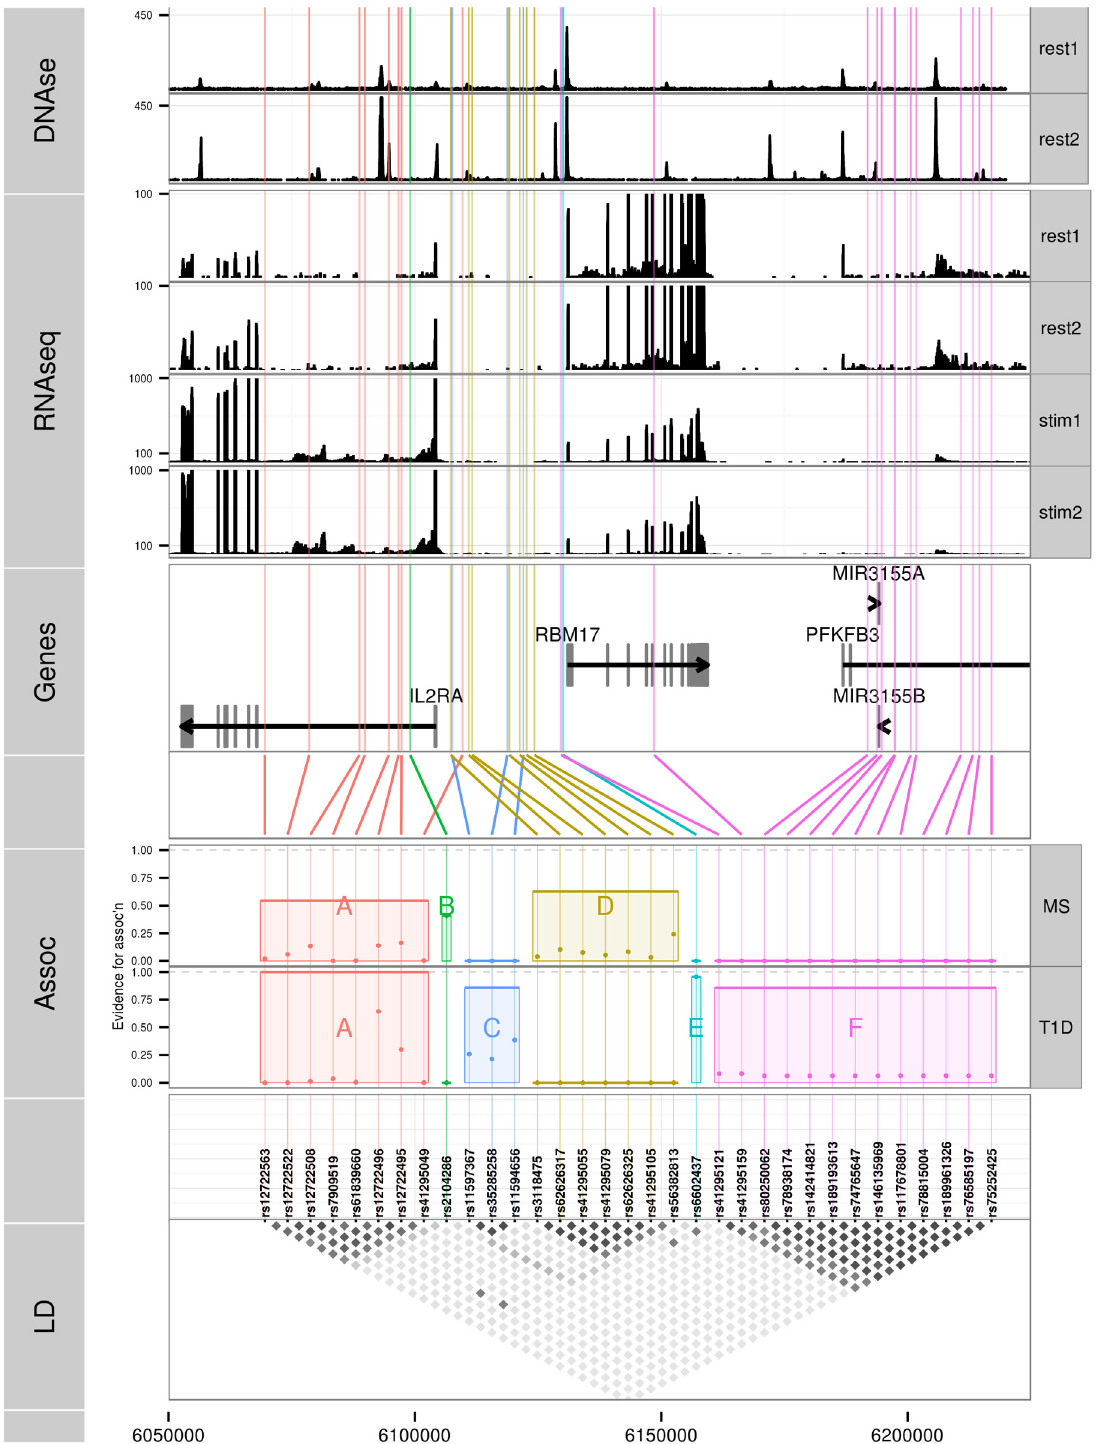
Fig 3. Six sets of SNPs can best explain the association of T1D and MS in the chromosome 10p15 region. LD : a heatmap indicating the r 2 between SNPs. Assoc : MPPI for MS and T1D the SNPs in a group, with total MPPI across a SNP group, gMPPI, indicated by the height of the shaded rectangle (see Table 5 for numerical details). SNP groups are labelled by the letters A-F for reference. SNPs in this track are ordered by SNP group for ease of visualisation. Genes : SNPs are mapped back to physical position and shown in relation to genes in the region. RNAseq : read counts in two pooled replicates of